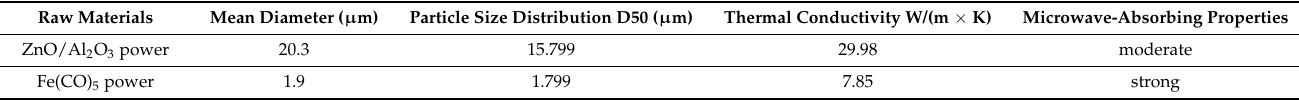
Table 1. Properties of powder